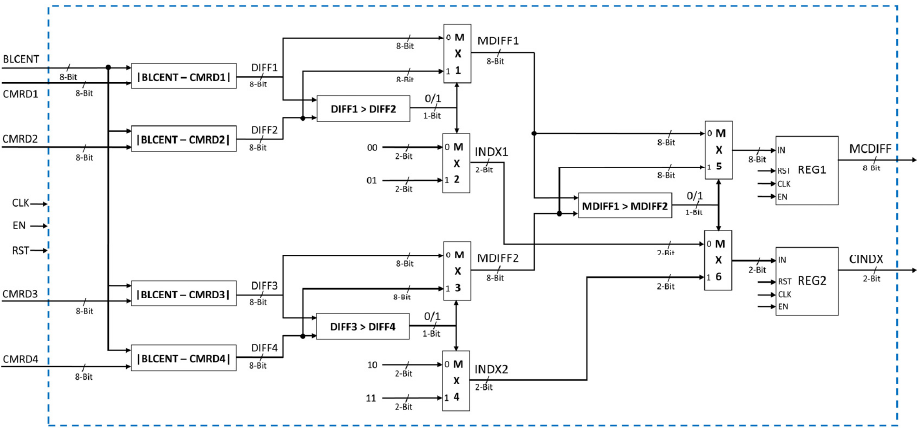
Figure 6. Proposed VLSI architecture of Minimum Centroid Difference Computation Module.